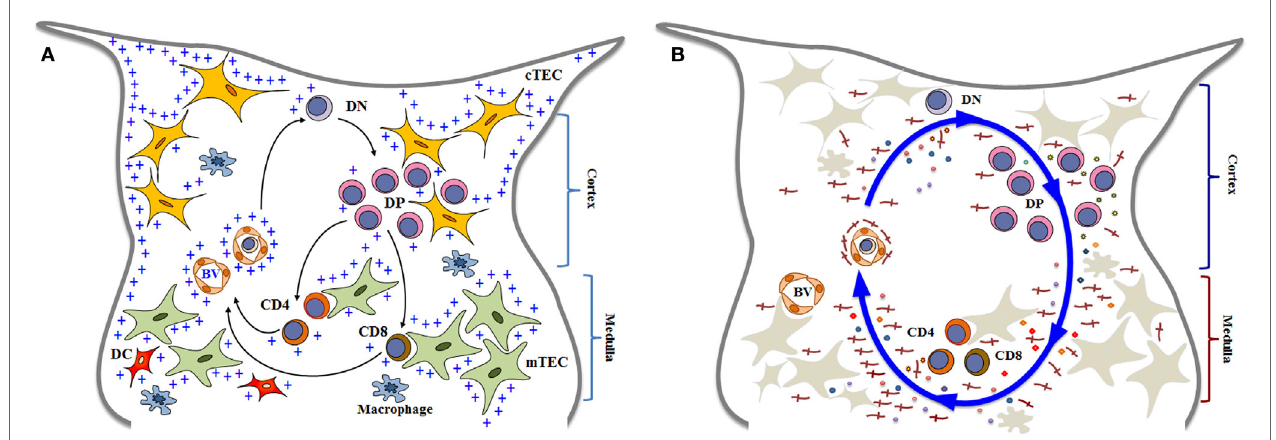
FiGURe 1 | Simplified diagrams of thymocyte differentiation and migration, in the context of the thymic microenvironment, according to a multivectorial migratory pattern . In (A) , we show that bone marrow-derived T-cell precursors enter the thymus through blood vessels (BV) in the corticomedullary junction of thymic lobules. CD4 − CD8 − double negative (DN) immature thymocytes then migrate to the outer cortex, where they interact with cortical thymic epithelial cells (cTEC) and differentiate into CD4 + CD8 + double positive (DP) cells. These cortical thymocytes will be able to continue to interact with microenvironmental cells as they migrate to the medulla, and positively selected cells will become either CD4 single-positive (CD4 SP) or CD8 single-positive (CD8 SP) cells, by interacting with medullary TEC (mTEC) or dendritic cells (DC) the medulla. In addition to cell–cell interactions between thymocytes and the microenvironmental components, developing thymocytes can be influenced by components of the extracellular matrix (herein labeled with blue crosses). Mature SP thymocytes will leave the organ by entering blood vessels that will allow them to find the way to colonize the T-cell-dependent zones of peripheral lymphoid organs. Although not showed in the cartoon, most thymocytes actually die and are rapidly phagocytized by macrophages. In (B) , we illustrate that thymocyte migration occurs as a result of multiple interactions, following a multivectorial pattern throughout the thymic lobule. In this panel, we emphasize the importance of LM (the red crosses) as one vector involved in thymocyte migration, comprising both immature and mature cells. Diagrams modified from Ref. (16, 18, 81, 128,